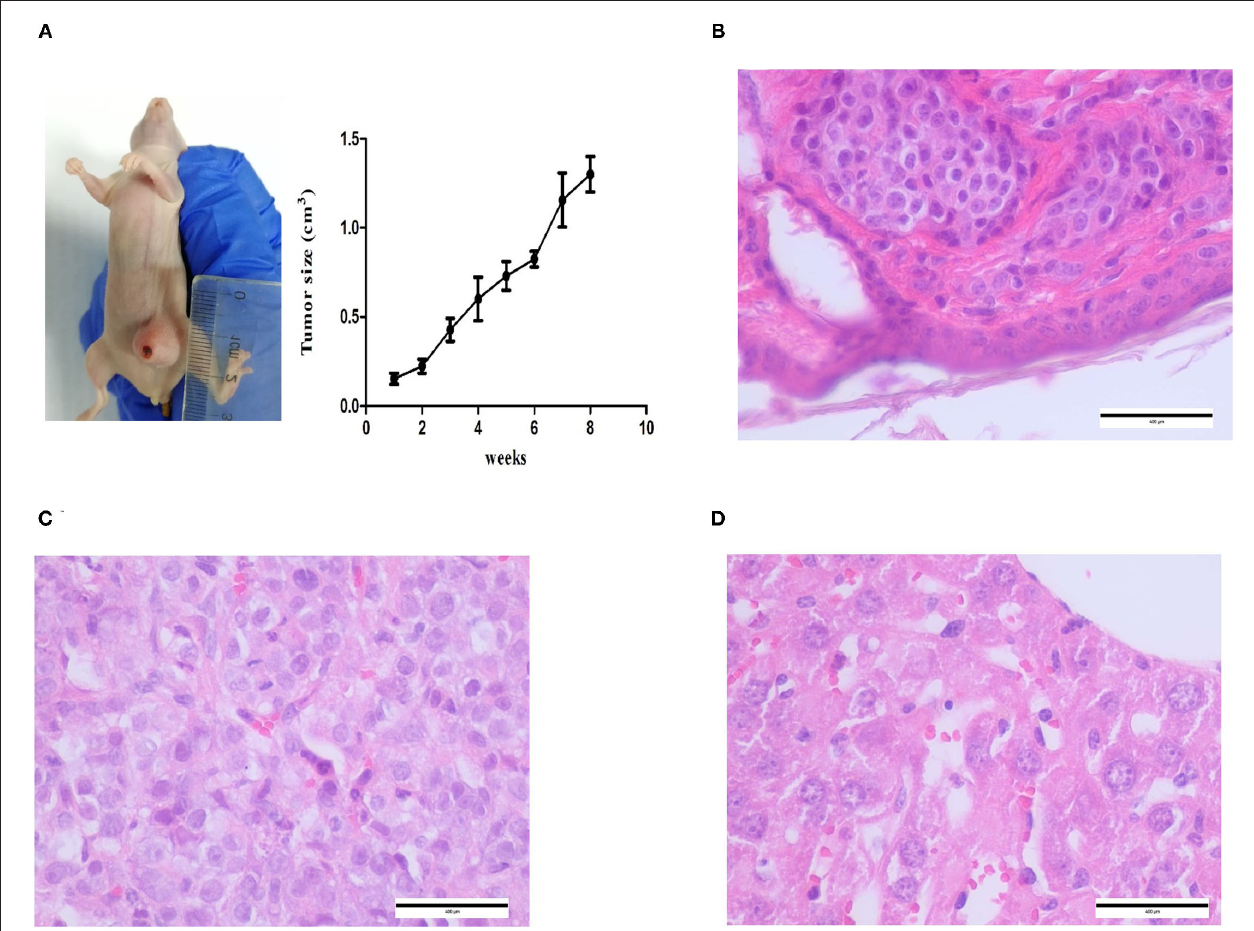
FIGURE 9 | Mice inoculated with CMT-1026. (A) CMT-1026 mouse xenografts and tumor volume detection. (B) The subcutaneous dermis exhibited infiltrating cellular growth. (C) Glandular epithelial cells of lungs excised from xenografted mice. (D) Overall heteromorphism of liver cells was observed, along with increased nucleoli and